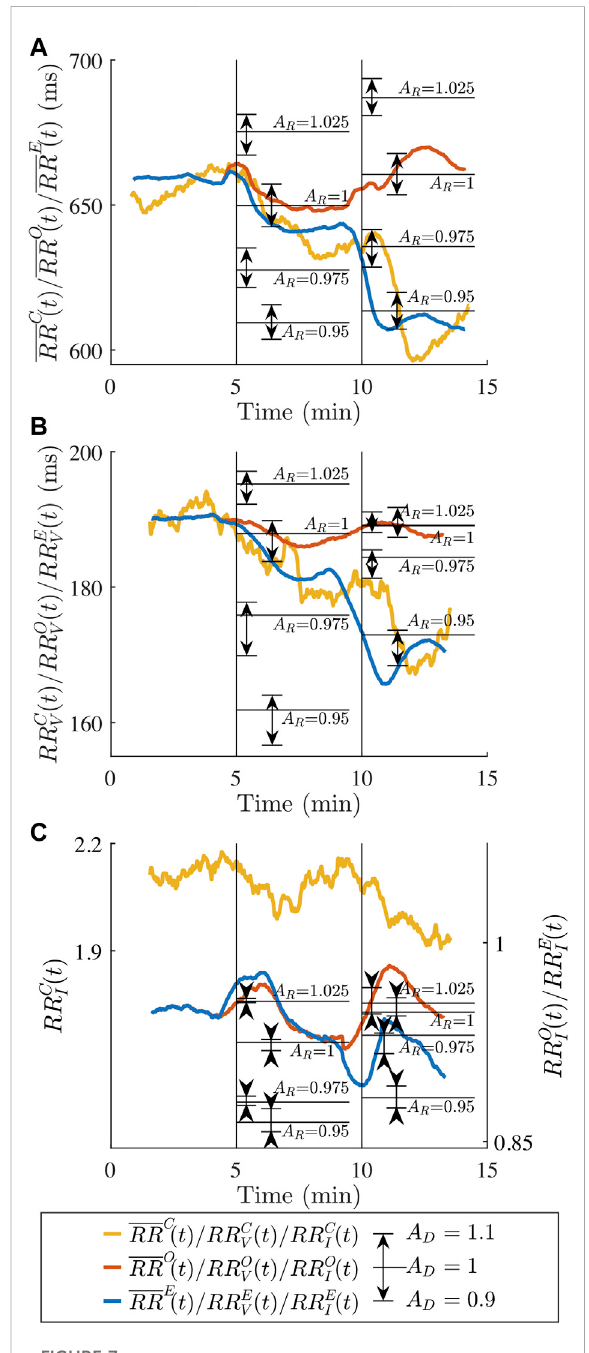
FIGURE 7 Average clinical RR series characteristics (A) RR C ( t ) (B) RR C V ( t ) and (C) RR C I ( t ) (yellow) and average simulated RR series characteristics for the original model (A) RR O ( t ) (B) RR O V ( t ) and (C) RR O ( t ) (red) and average simulated RR series characteristics I for the extended model (A) RR E ( t ) (B) RR E V ( t ) and (C) RR E I ( t ) (blue). Thedashedblacklinesmarkthetransitionbetweenthesupineand HDT, and HDT and HUT, respectively. Horizontal black lines show 5-min averages of RR E ( t ) , RR E V ( t ) and RR E I ( t ) during HDT or HUT with A R as indicated and A D = 1. Arrows show the impact of perturbing A D by +0.1 (arrow pointing up) or − 0.1 (arrow pointing